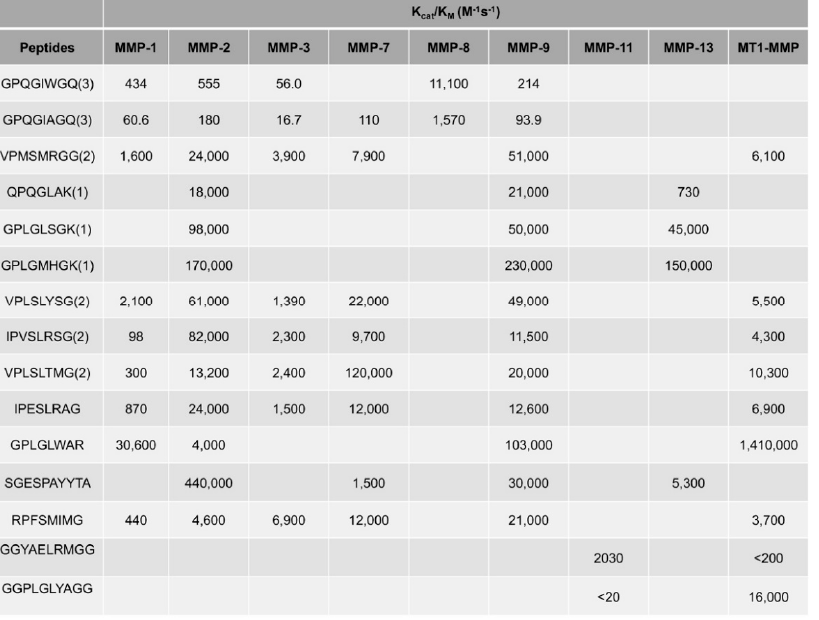
Figure 1. Kinetic parameters for MMP-cleavable peptides [33,38]. Reprinted with permission from Copyright © 2010 Elsevier Ltd, and Copyright © 2016 Elsevier Ltd.